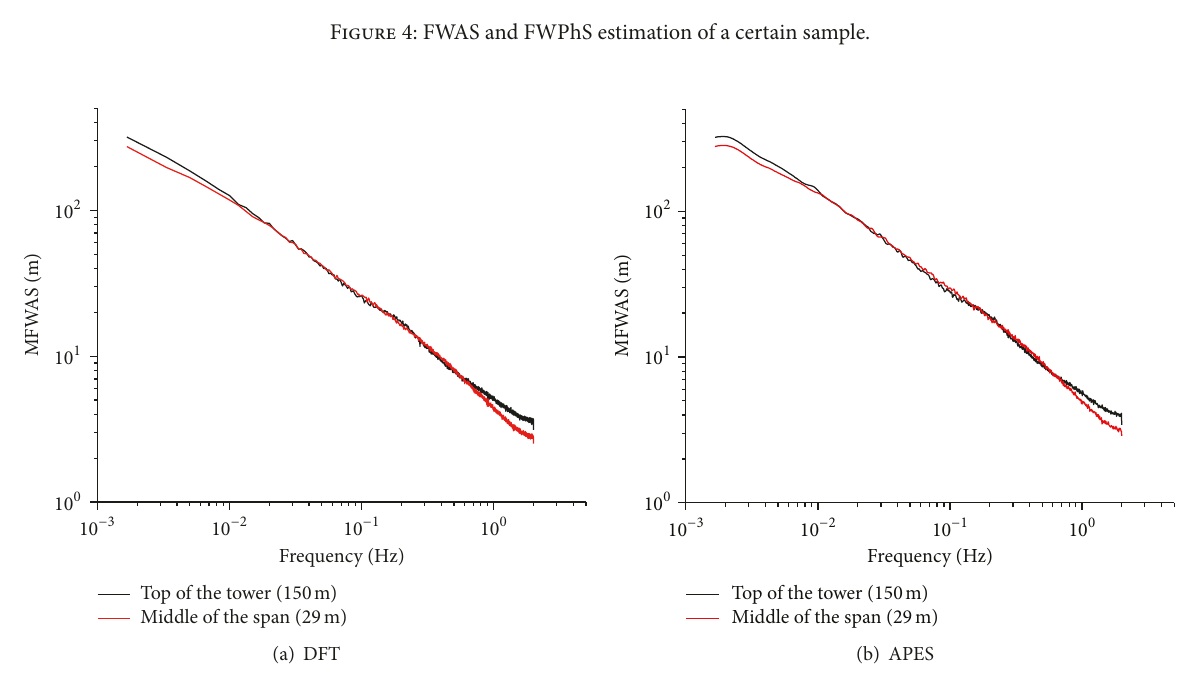
Figure 5: Mean of measured FWASs obtained using the two